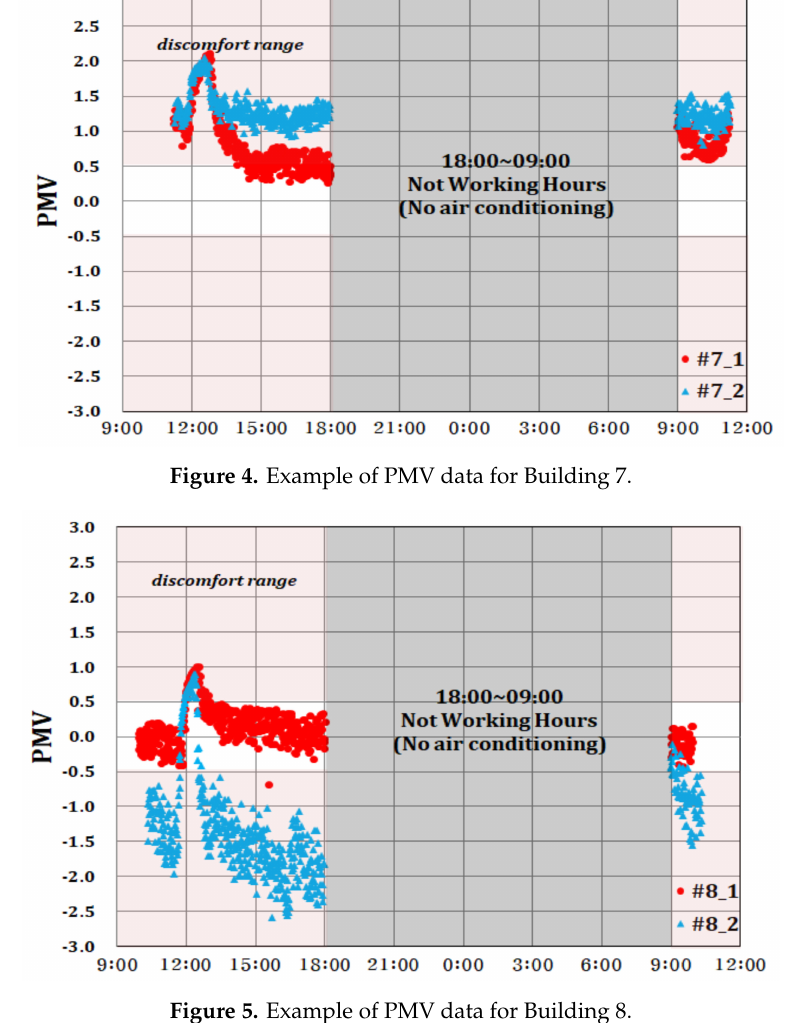
Figure 5. Example of PMV data for Building 8.